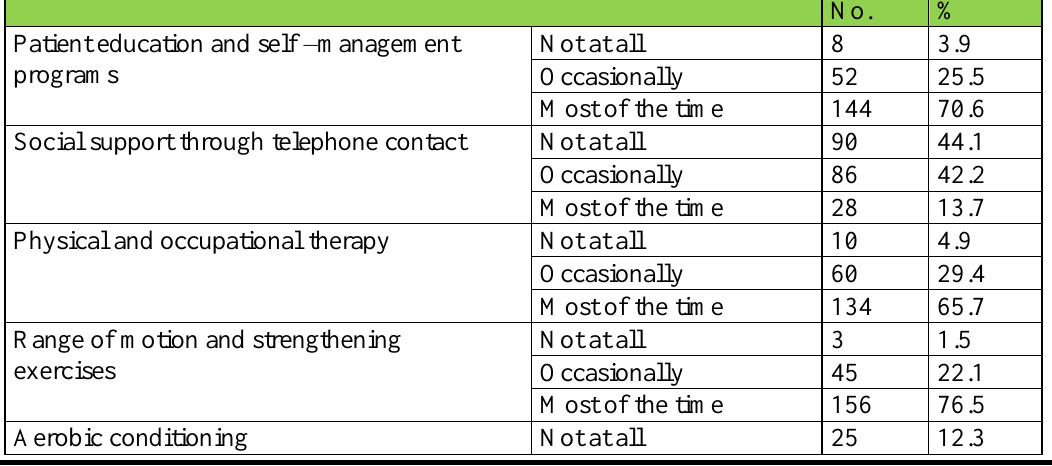
Table.8. Practices of PHC physicians toward